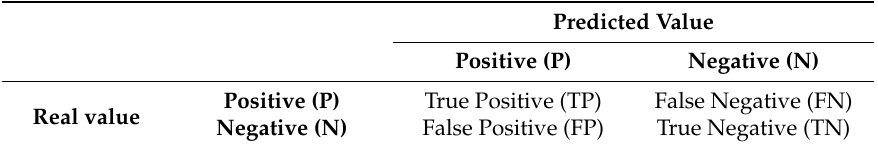
Table 1. Confusion matrix for binary